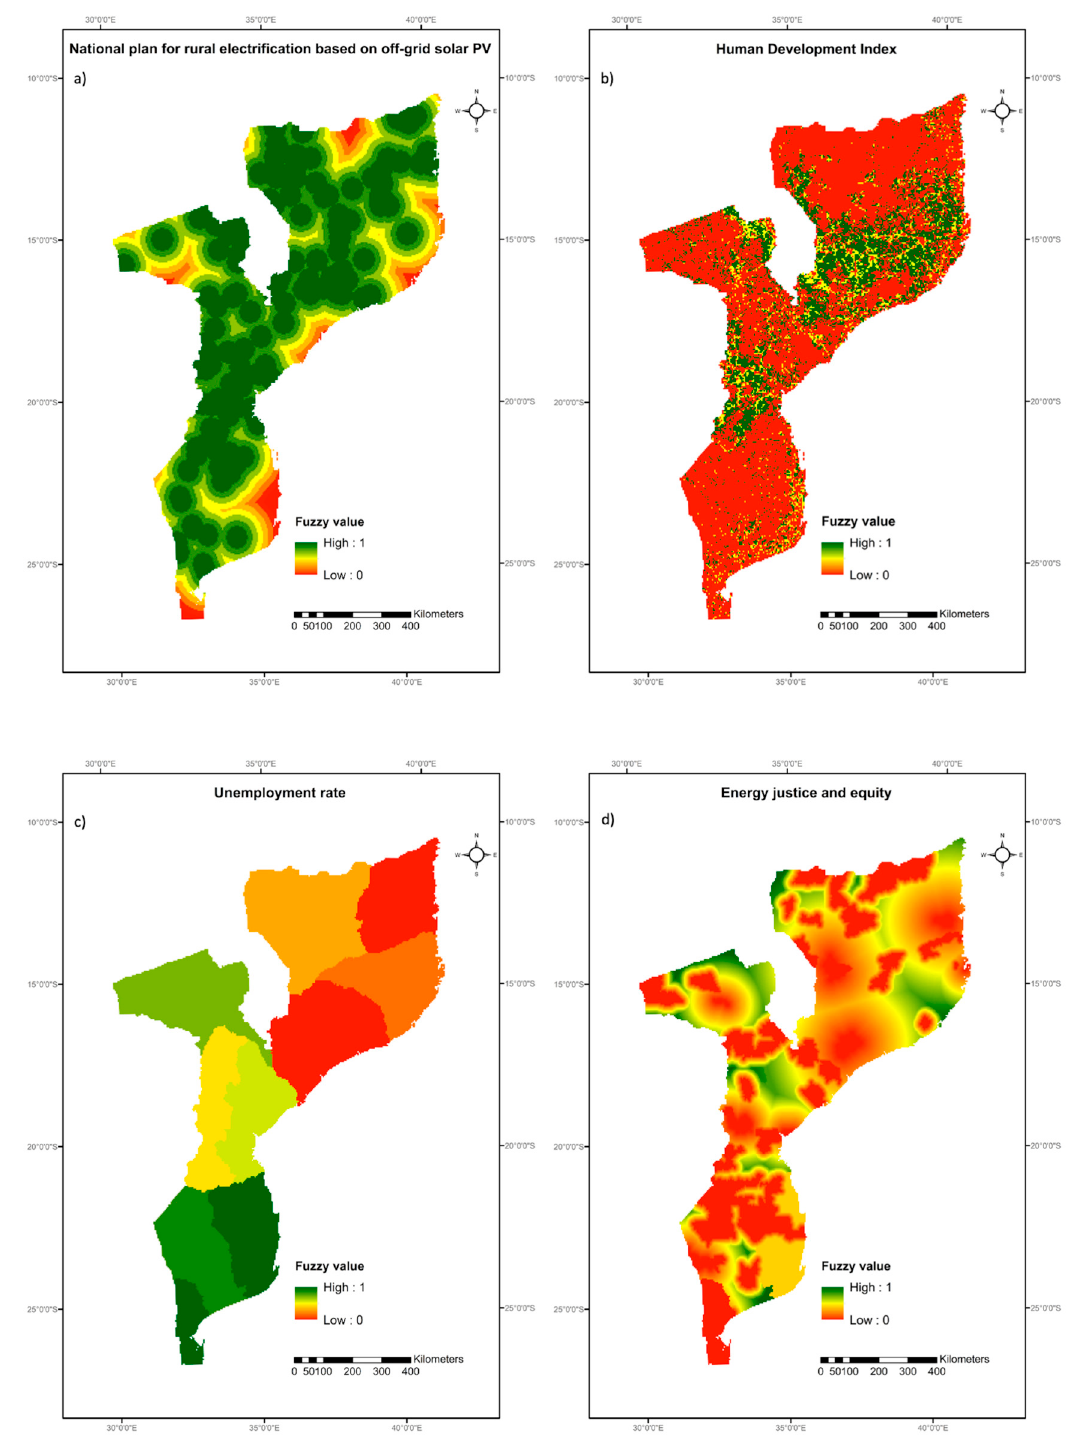
Figure 7. Standardized (reclassified and fuzzified) raster maps of institutional criteria and social criteria to the spatial suitability of off-grid solar PV microgrid projects in Mozambique. ( a ) National plan for rural electrification, ( b ) Human Development Index, ( c ) unemployment rate, and ( d ) energy justice and